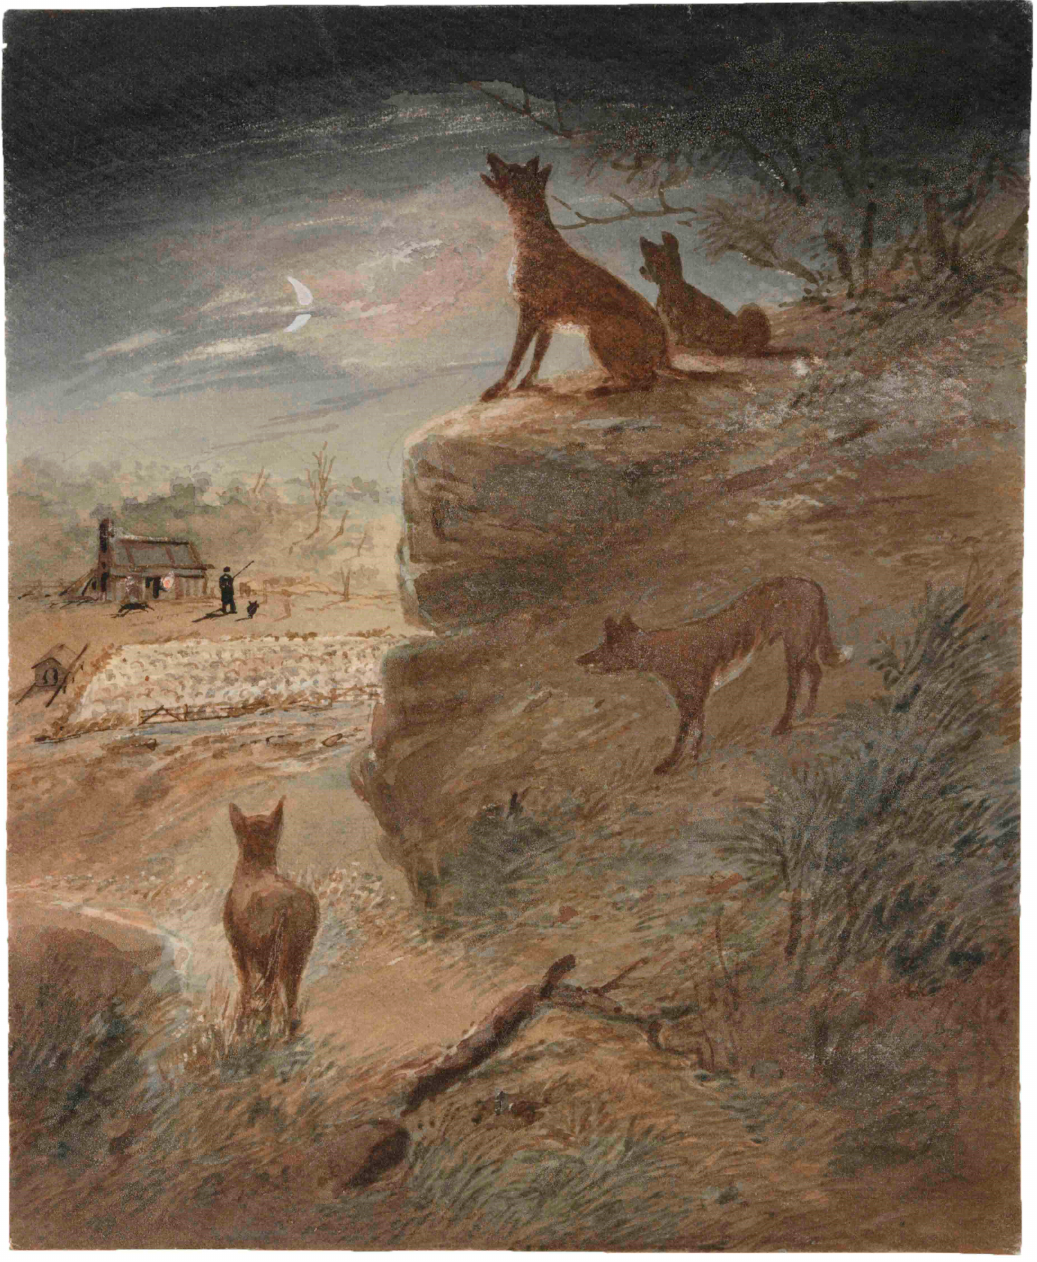
Figure A2. A depiction of dingoes howling near a shepherd’s hut. Title: ‘Prospecting at an out station. Dingoes, or wild dogs of the Bush prowling round the sheep fold; Dr Doyle’s sketch book, ca. 1862–1863/John Thomas Doyle & Samuel Thomas Gill’ (PXA 1983). Reproduced with permission of the State Library of New South Wales.